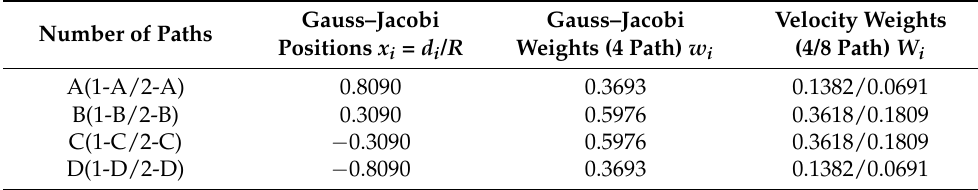
Table 1. Path position and path weight.